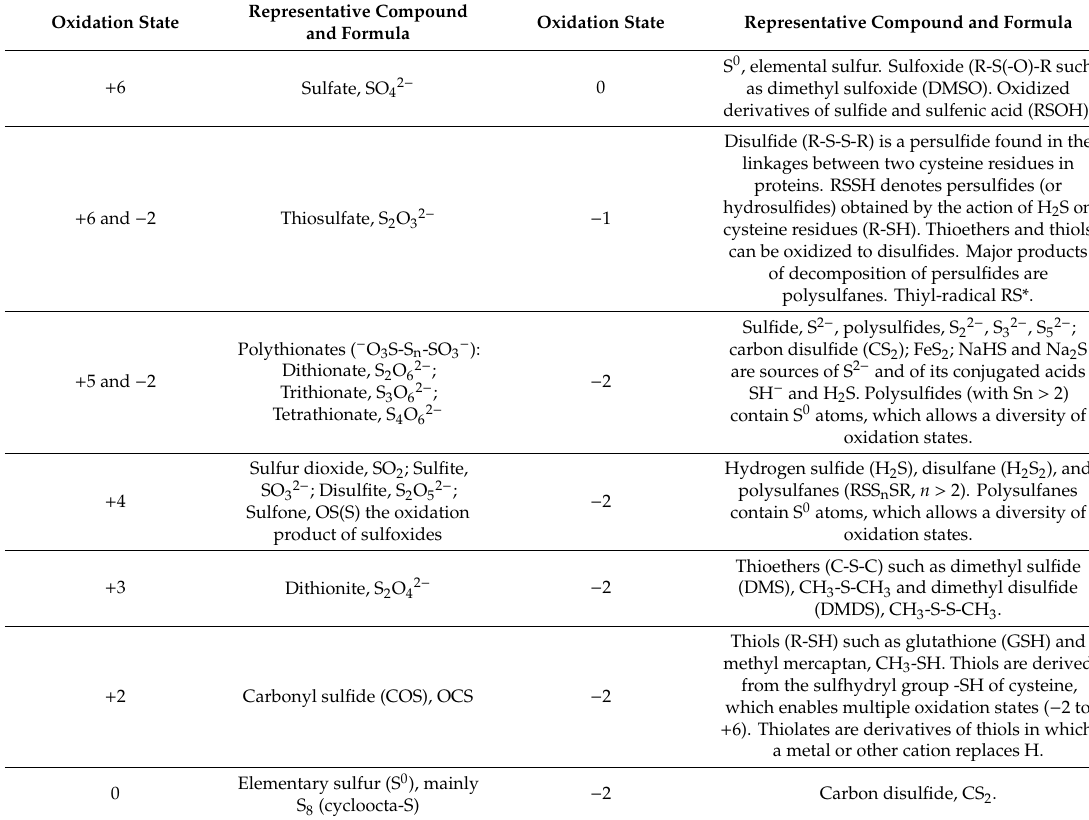
Table 1. Representative sulfur compounds and their oxidation